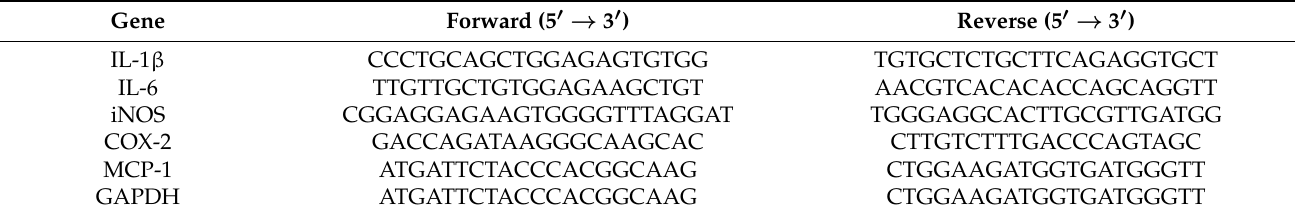
Table 1. Nucleotide sequences of primers used in